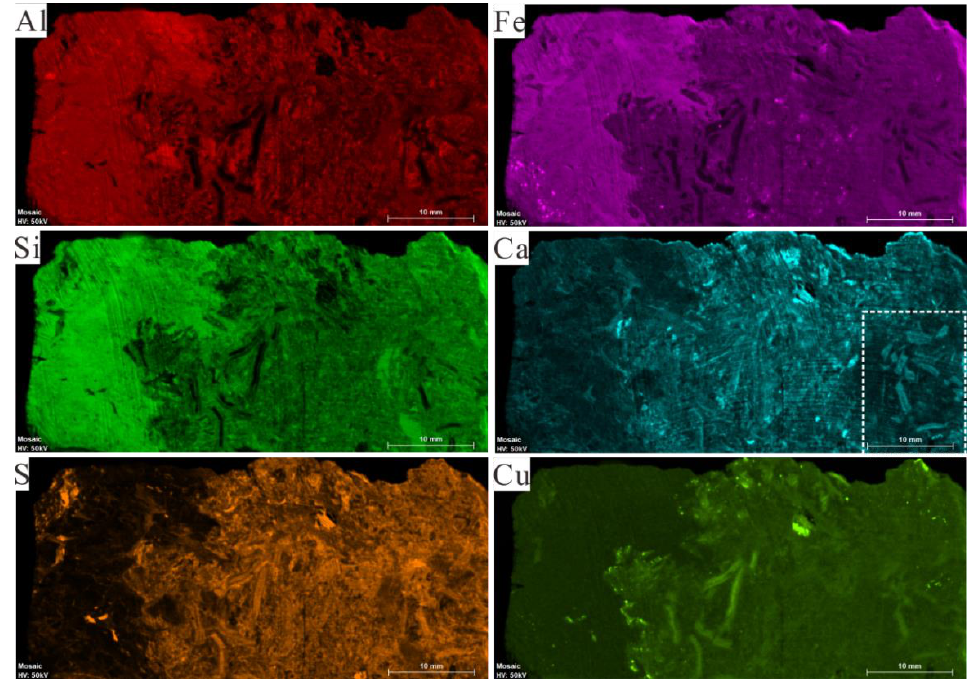
Figure 5. Elemental maps of Al, Fe, Si, Ca, S, and Cu in the sample Y1 obtained by the scanning μXRF mapping technique. White boxed pieces appear to be obviously plant debris.